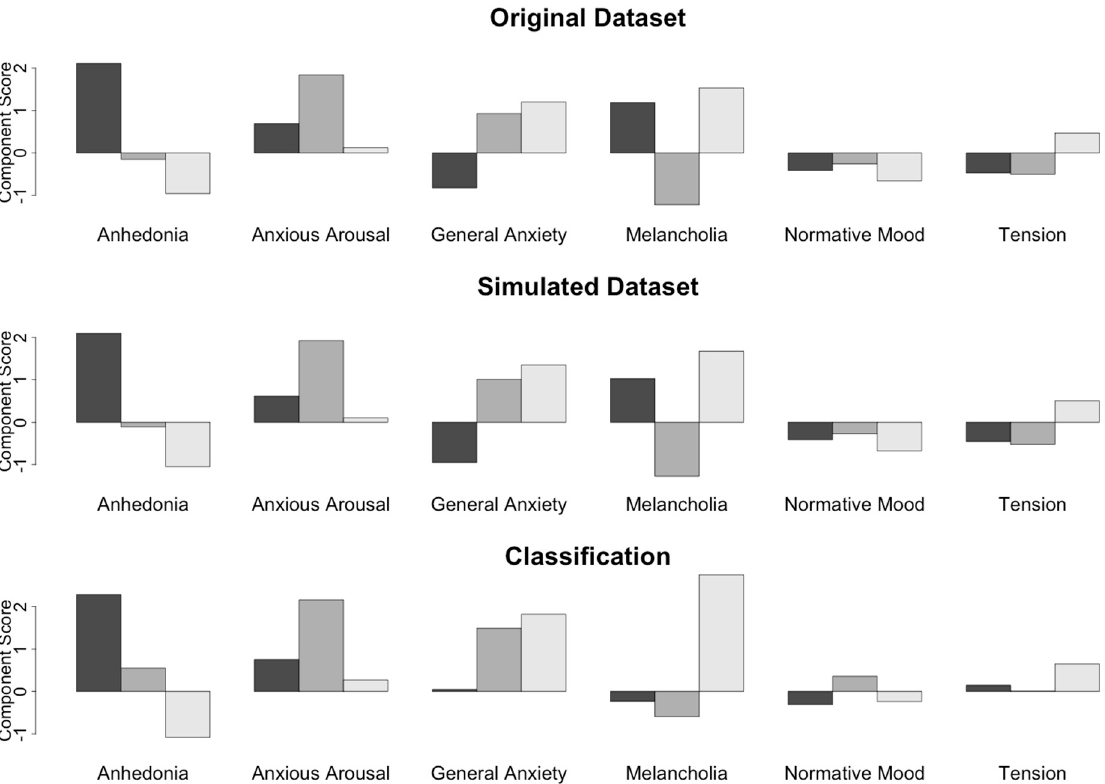
Figure 1. Linear discriminant model to classify subjects. The original dataset (top) was simulated (middle) using a sample of normally distributed component scores with the same means and standard deviations as the six symptom profile subtypes identified in the original dataset. A linear discriminant model based on these profiles was then constructed and used to classify subjects based on their symptom component scores